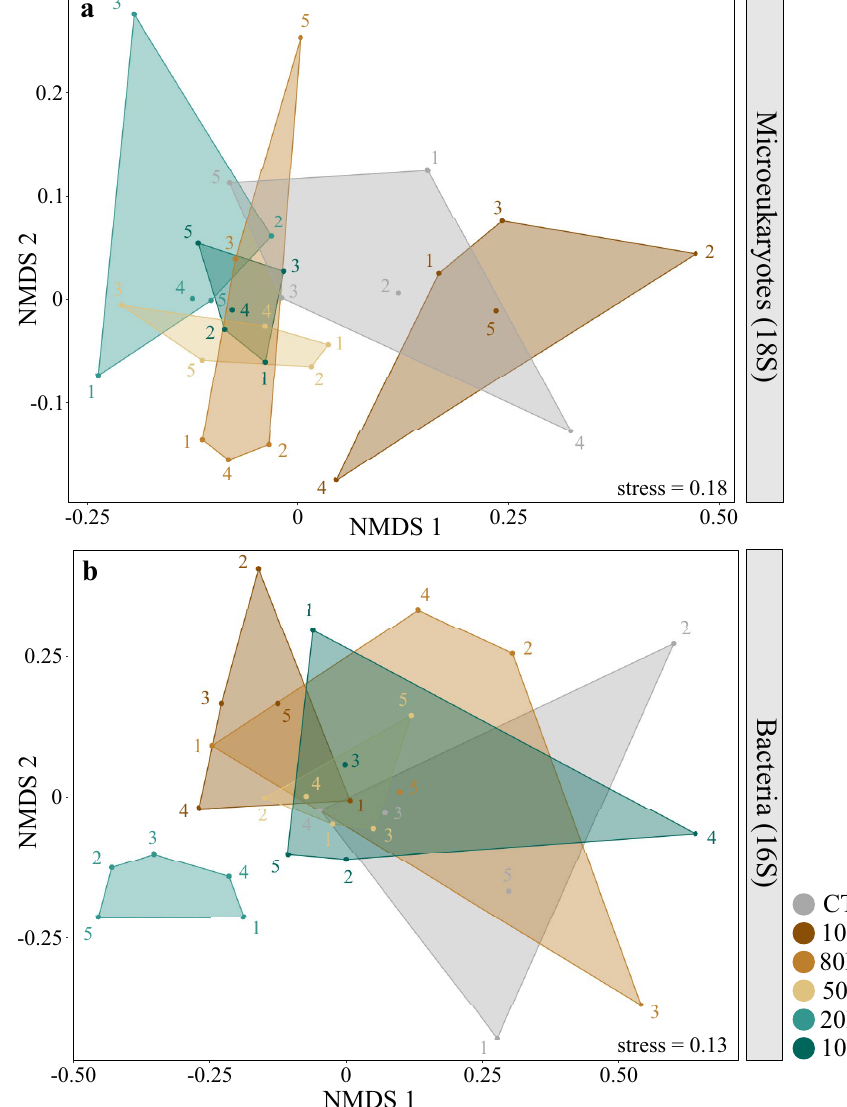
Figure 3. NMDS ordination plots based on Sørensen distance matrices of ( a ) microeukaryotic and ( b ) bacterial communities, calculated from 18 and 16S rRNA ASVs presence/absence, respectively. The stress value for each ordination is displayed in the bottom right corner. See Fig. 6 for treatment codes in the